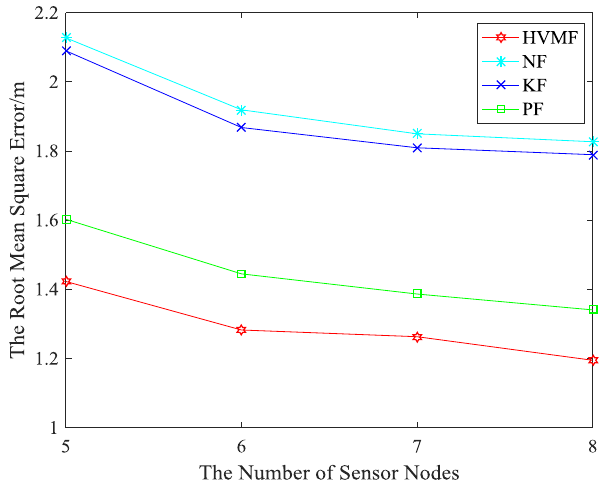
Figure 13. The number of beacon nodes versus RMSE.